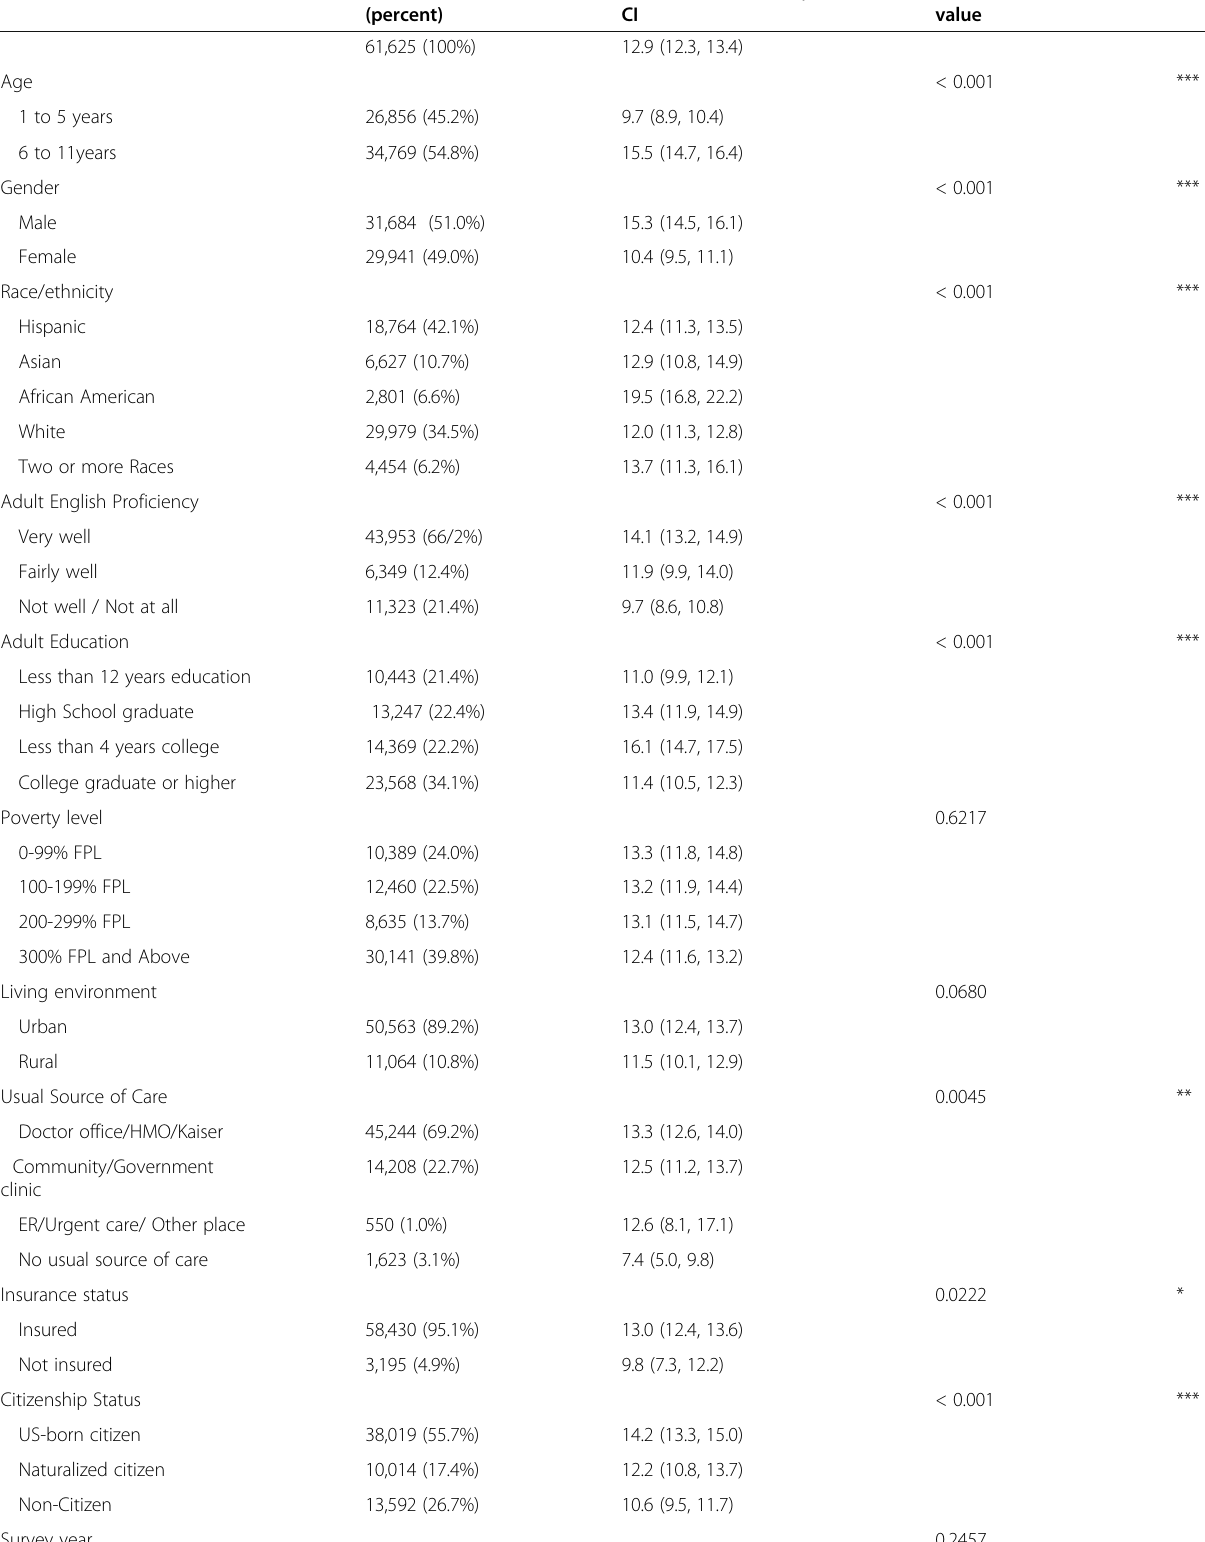
Table 1 Survey-weighted characteristics of Hispanic and White California children, 2001 to